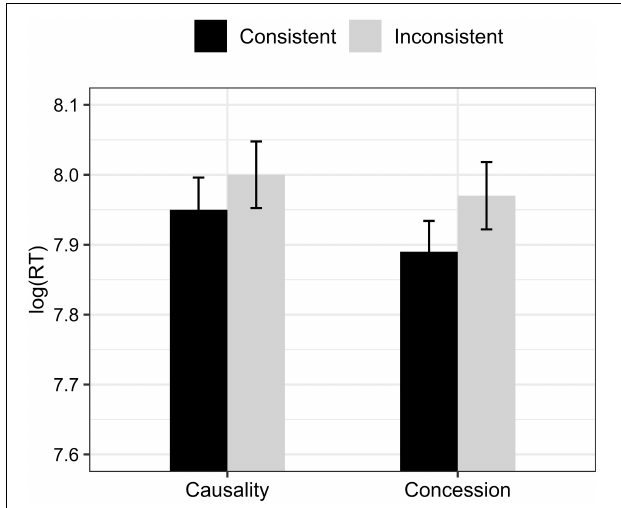
FIGURE 3 | Mean log-transformed response times in each condition of Experiment 3. Error bars represent one standard error.